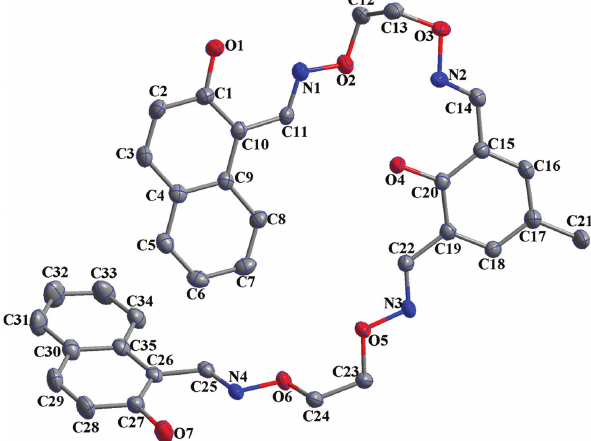
Table 1 contains crystallographic data and Table 2 contains the list of the atoms including atomic coordinates and dis- placement